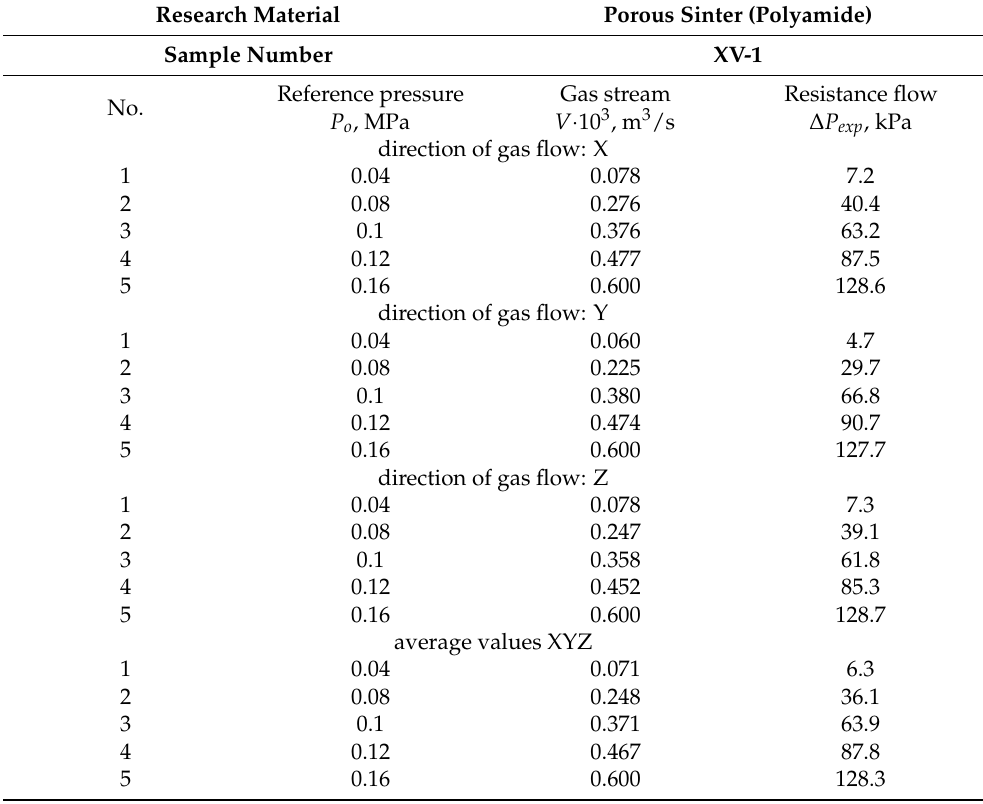
Table 2. The results of gas permeability measurements depending on the flow direction air, 18 ◦ C. Research